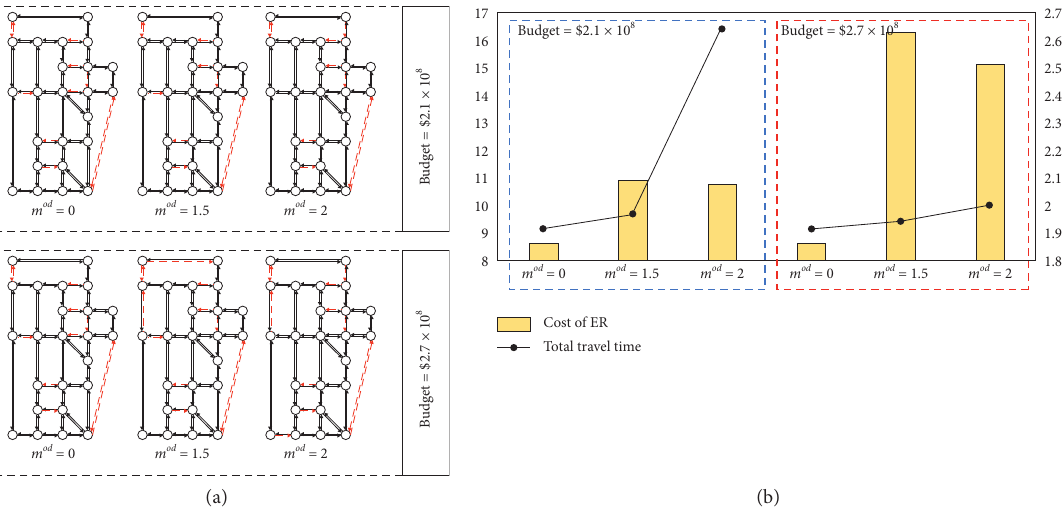
Figure 5: Comparison with different comfortable ranges ( m od : kWh ) . (a) Location designs ( m od : kWh ) . (b) Total travel time and cost of the ER.